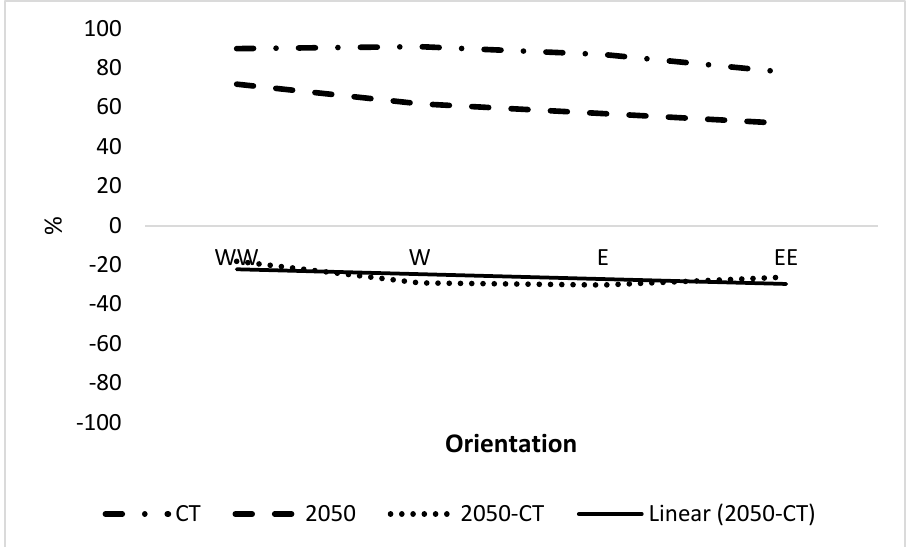
Figure 3. Longitudinal trend of combined suitable climate. WW, W, E and EE represent west-west, west, east and east-east, respectively, of Nigeria excluding parts with unsuitable climate for growing OP (Figure 2). CT is current time.